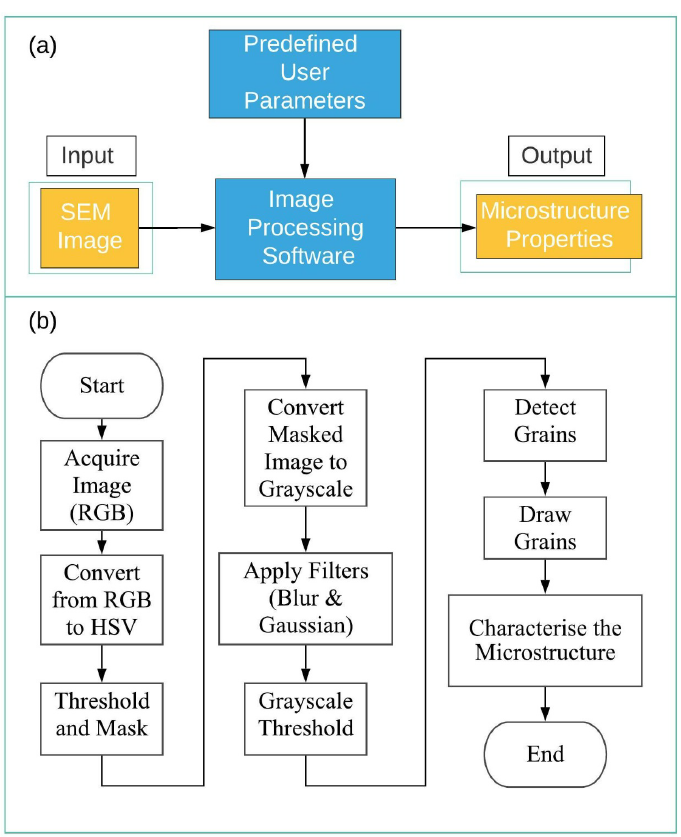
Figure 3. ( a ) Image processing software structure, (b ) Flowchart of the